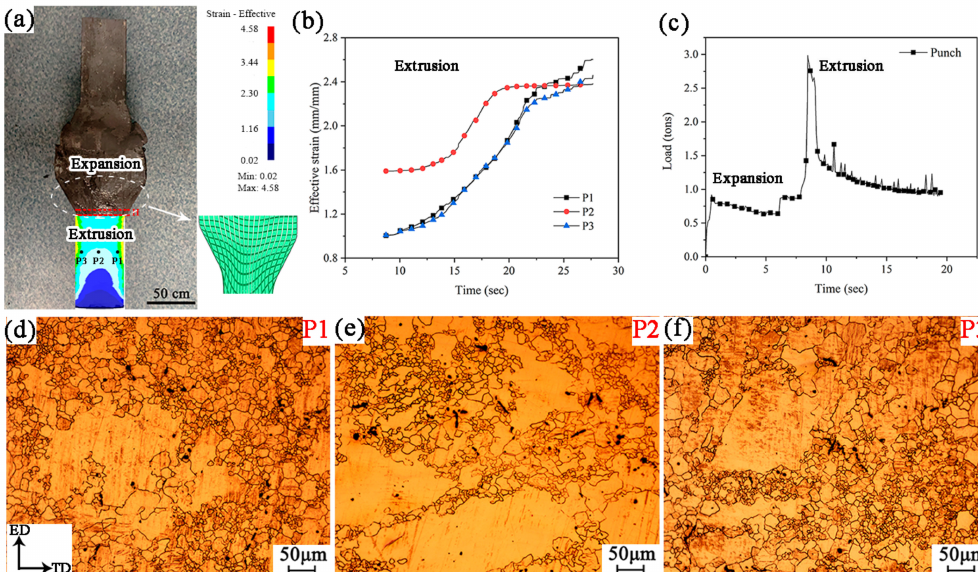
Figure 3. ( a ) Distribution of e ff ective strain; ( b ) plot of e ff ective strain of di ff erent deformation zones (Position (P) 1, 2, and 3); ( c ) finite element method (FEM) calculated force versus processing time; and ( d , e , f ) microstructures of 1 pass of CEE-AEC in P1, P2, and P3, respectively.